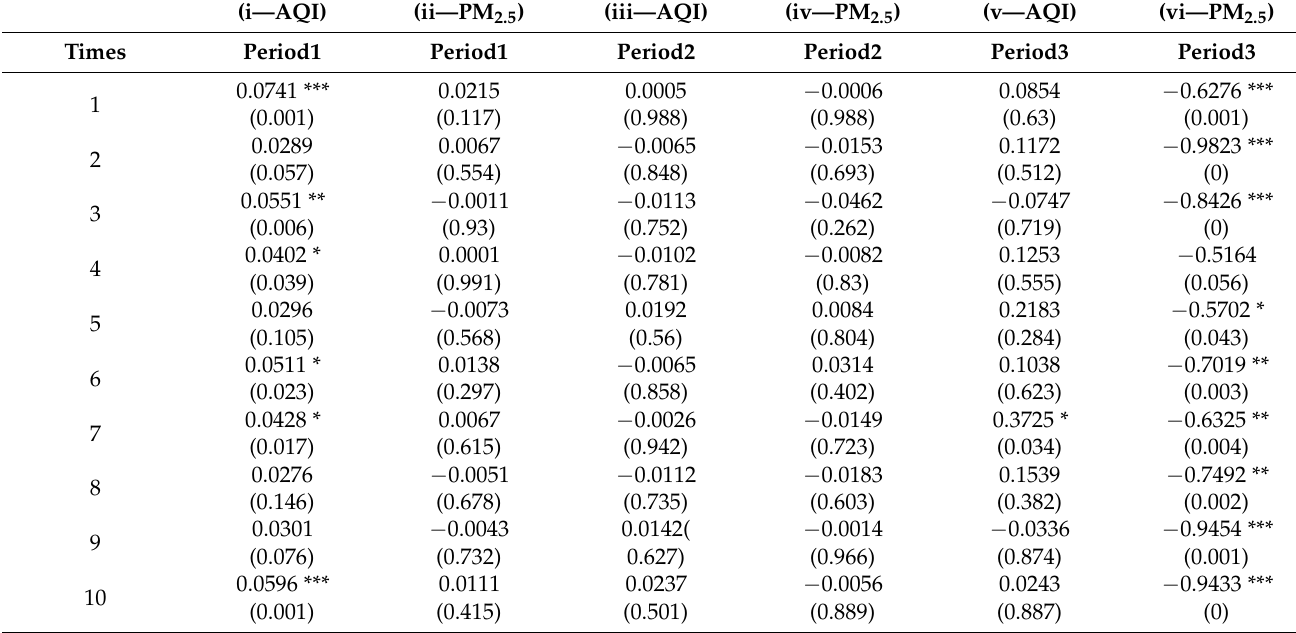
Table A7. Ten times of the effect’s estimation of air pollution on people’s activity on the randomly sampled sightseeing